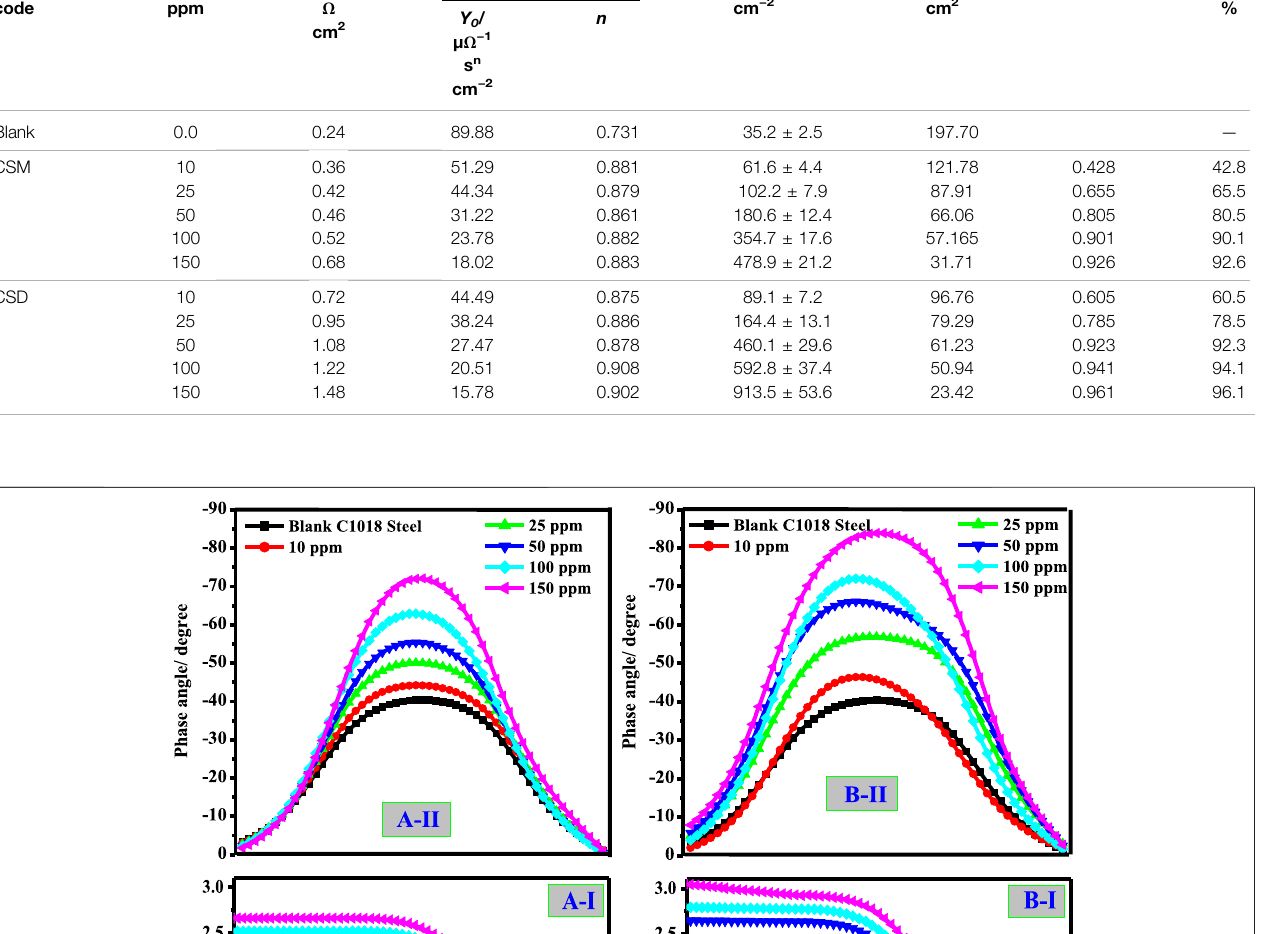
TABLE 2 | EIS parameters and inhibition ef fi ciency of C-steel in 3.5% NaCl saturated with CO 2 in the absence and presence of diverse doses of the prepared surfactants at 50 ± 1 ° C. Inhibitor code